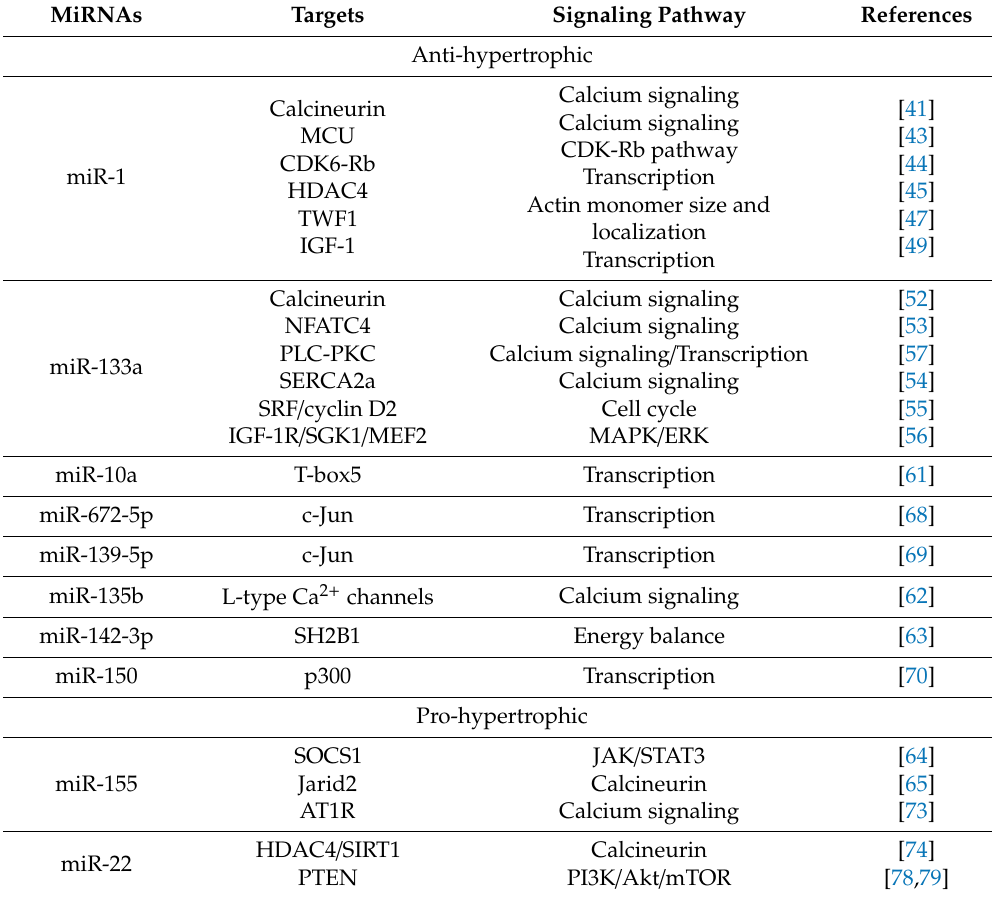
Table 1. Anti- and pro-hypertrophic miRNAs with their targets and the involved signaling pathways.